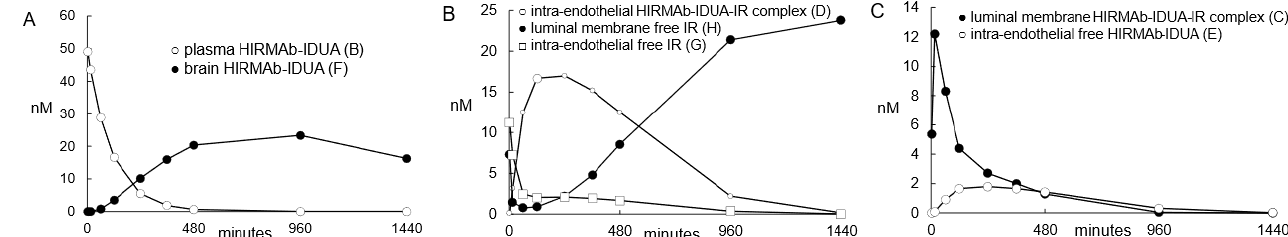
Figure 8. The concentration of IR model variables, B ( t ), F ( t ) ( A ); D ( t ), H ( t ), G ( t ) ( B ); and C ( t ), E ( t ) ( C ) is plotted from 0 to 1440 min following the IV administration of an ID of 2 mg/kg of the HIRMAb-IDUA fusion protein. The plot shows the unoccupied IR on the endothelial luminal membrane [variable H ( t ), Figure 5] increases to nearly 100% of total endothelial IR at t = 1440 min, as the HIRMAb-IDUA fusion protein [variable B ( t ), Figure 5] is cleared from plasma.